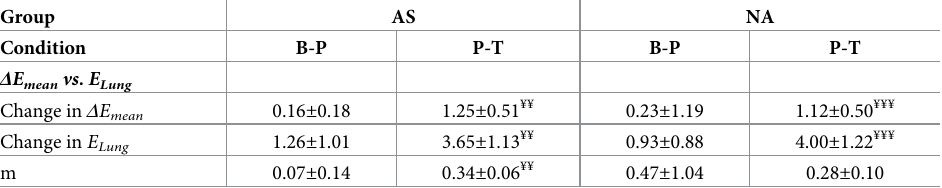
Table 3. Differences between peribronchial and segmental parenchymal expansion Δ E (Continued) . Group AS NA Condition B-P P-T B-P Δ E mean vs . E Lung Change in Δ E 0.16 ± 0.18 mean Change in E Lung 0.28 ± 0.10 B, baseline; P, post MCh challenge; T, total lung capacity; AS, asthmatics; NA, non-asthmatics; Δ E , difference in parenchyma expansion between segmental and peribronchial; E , average lung parenchyma expansion; Δ E , Lung mean average difference between segmental and peribronchial expansion after accounting for the vertical location dependence; m, slope. See Abbreviations. Paired t-test comparison between bronchoconstriction by MCh (B-P) and deep inhalation (P-T); ¥ p < 0.05, ¥¥ p < 0.01, ¥¥¥ p < 0.001